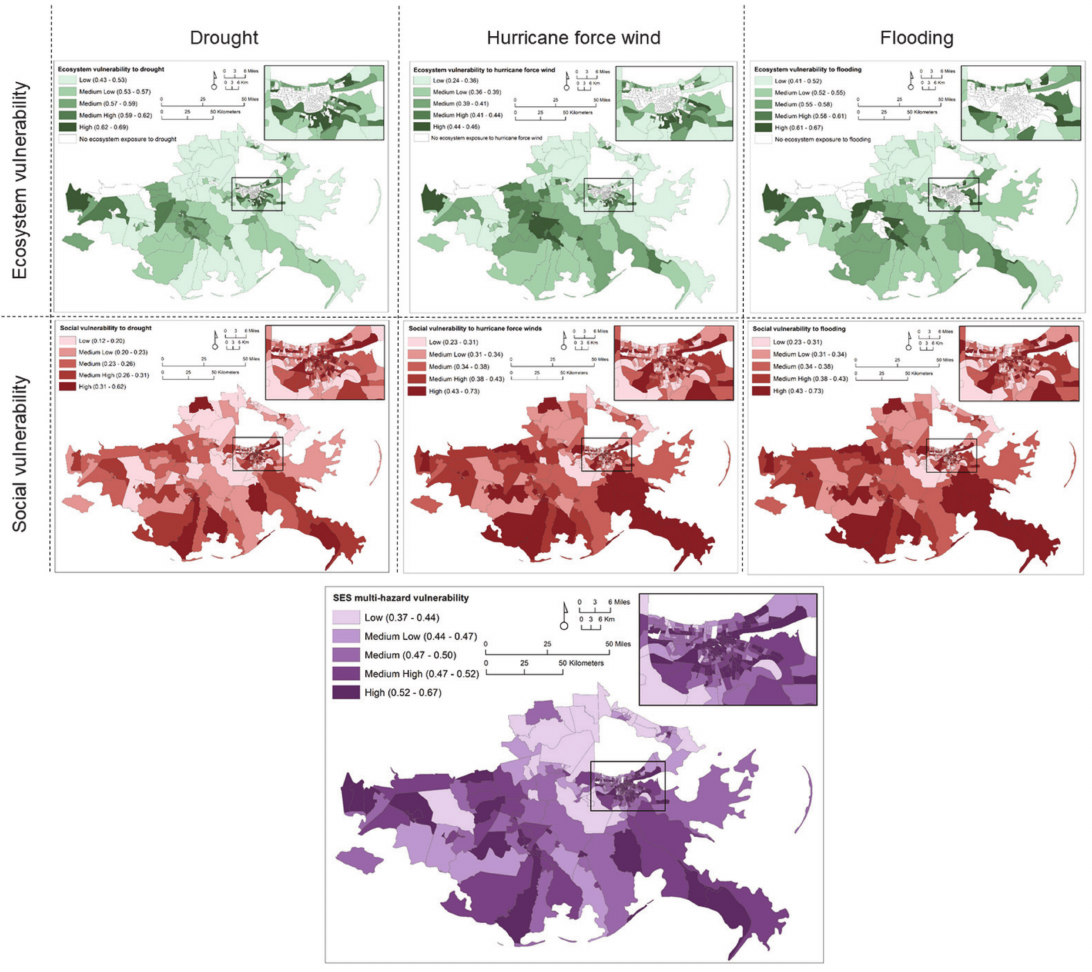
Figure 3. Social and ecosystem vulnerability for the hazards drought, hurricane force wind, and coastal flooding and Social-ecological System (SES) multi-hazard vulnerability. Ecosystem vulnerability is displayed only for those tracts in which there is some ecosystem exposure for the respective hazard. Because there is little ecosystem area among tracts in New Orleans, these are mostly shown in white (no ecosystem